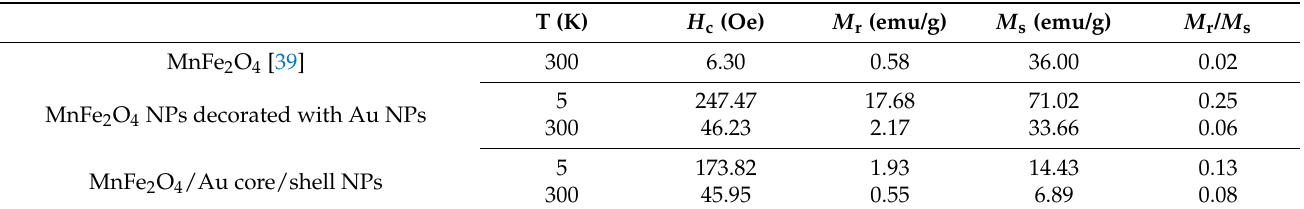
Table 4. Coercive field ( H c ), remnant magnetization ( M r ), saturation magnetization ( M s ), and magnetic squareness ratio ( M r / M s ) of MnFe 2 O 4 /Au core/shell nanoparticles and MnFe 2 O 4 NPs decorated with Au, at 5 K and 300 K. The magnetic properties of MnFe 2 O 4 nanoparticles are also shown for comparison [39].